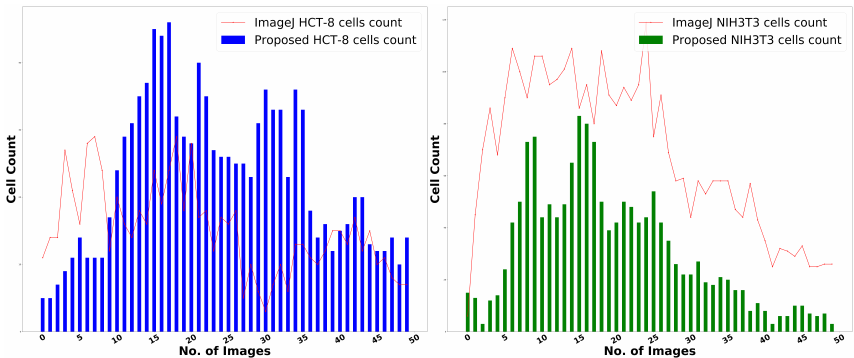
Figure 12. BCC and GCC comparison between ImageJ software and proposed methodology from periphery to core of 3D cell spheroid for 2:0.5 ratio